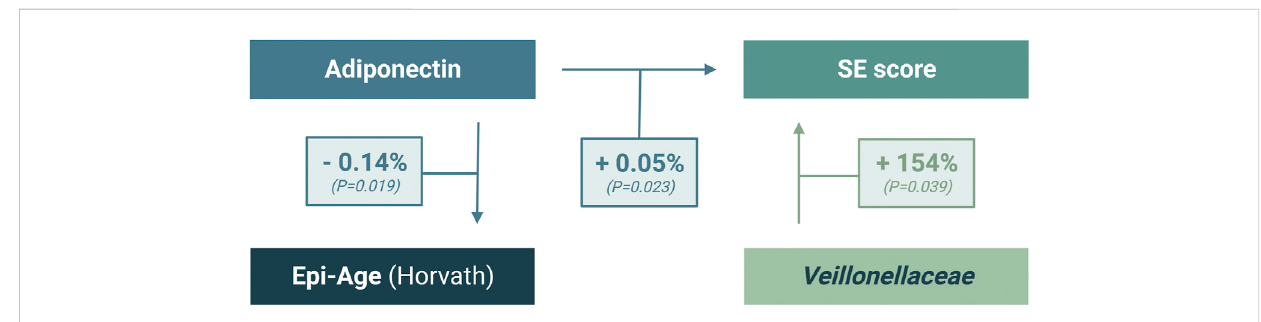
FIGURE 6 Multiple-regression analysis of signi fi cant interaction between SE scores, adiponectin, and gut microbial abundance of